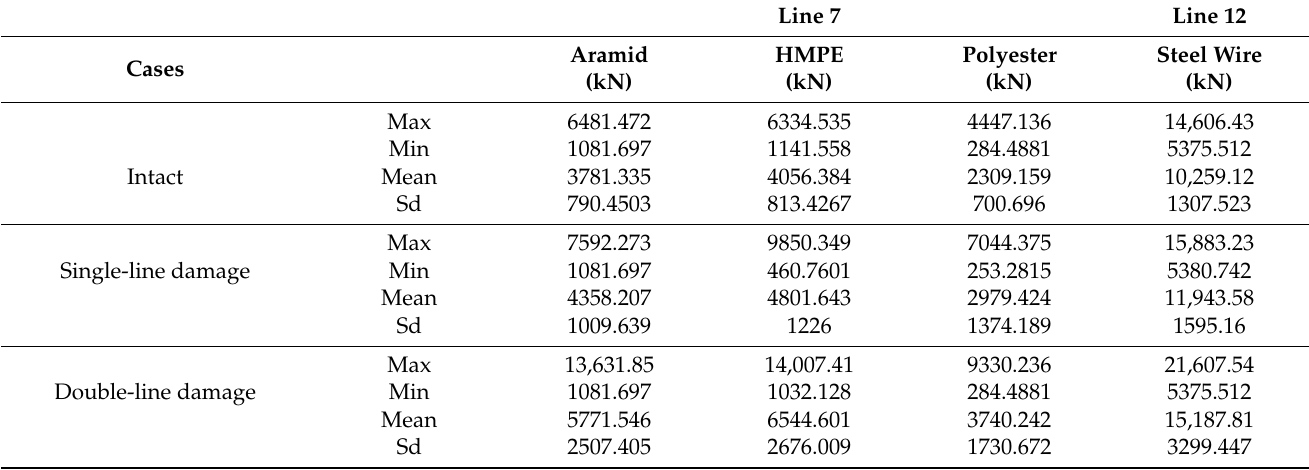
Table 9. Statistical comparison of mooring tension for representative lines after different failure